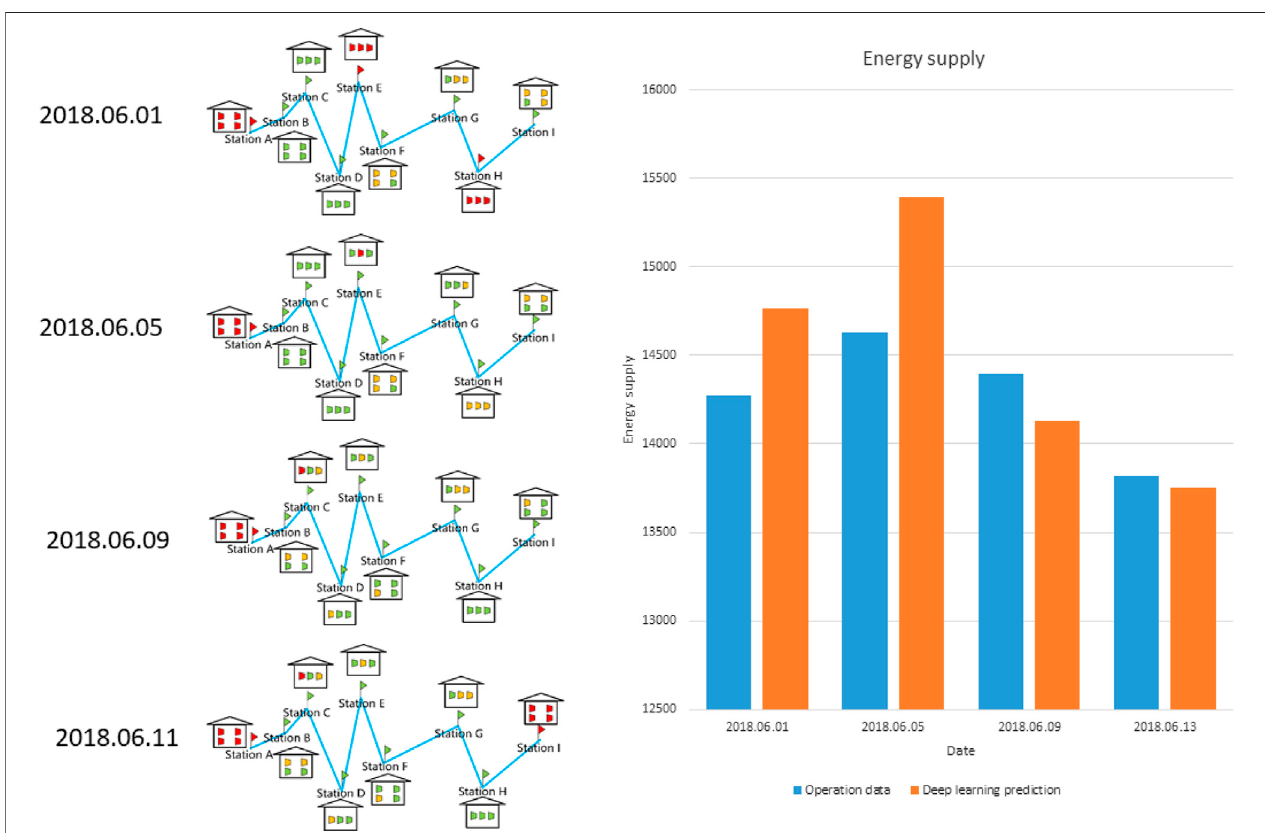
FIGURE 10 | Prediction performance in realistic operation